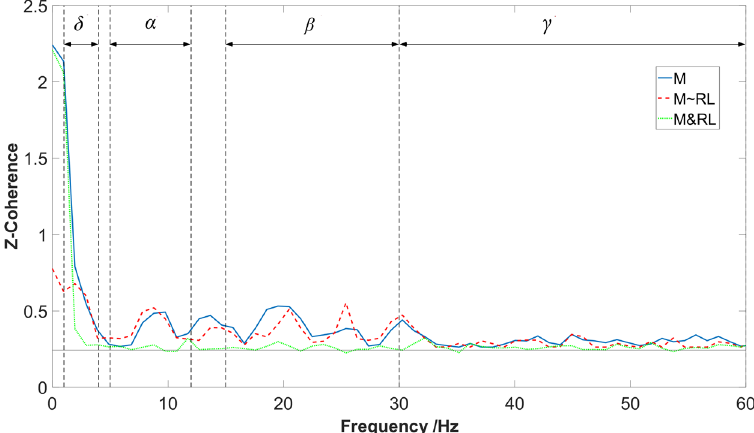
Figure 2. An example of the different coherence calculations from a representative subject. The solid blue line represents the total coherence of middle finger ( M ); the red dashed line represents the partial coherence residual of middle finger after removing any synchrony generated from ring-little finger ( M ~ RL ); and the green dotted line represents the cross-compartment coherence of middle and ring-little fingers ( M&RL ). The horizontal line shows the 95% confidence